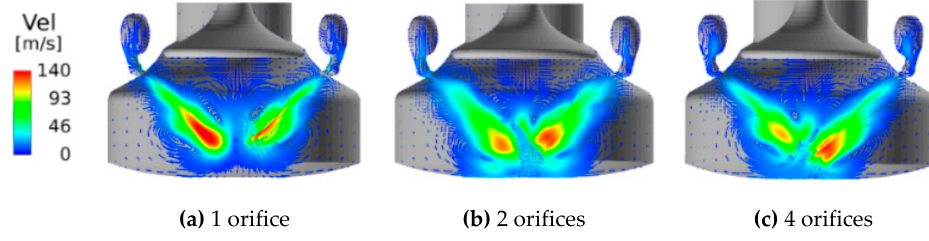
Figure 7. Flame velocity vector distribution.